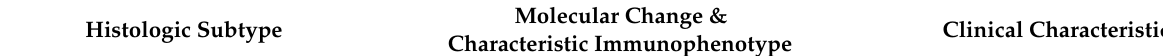
Table 1. 2016 WHO classification of mature T-cell and natural killer cell (NK) neoplasms, with highlights of molecular, immunophenotype and clinical features of most common